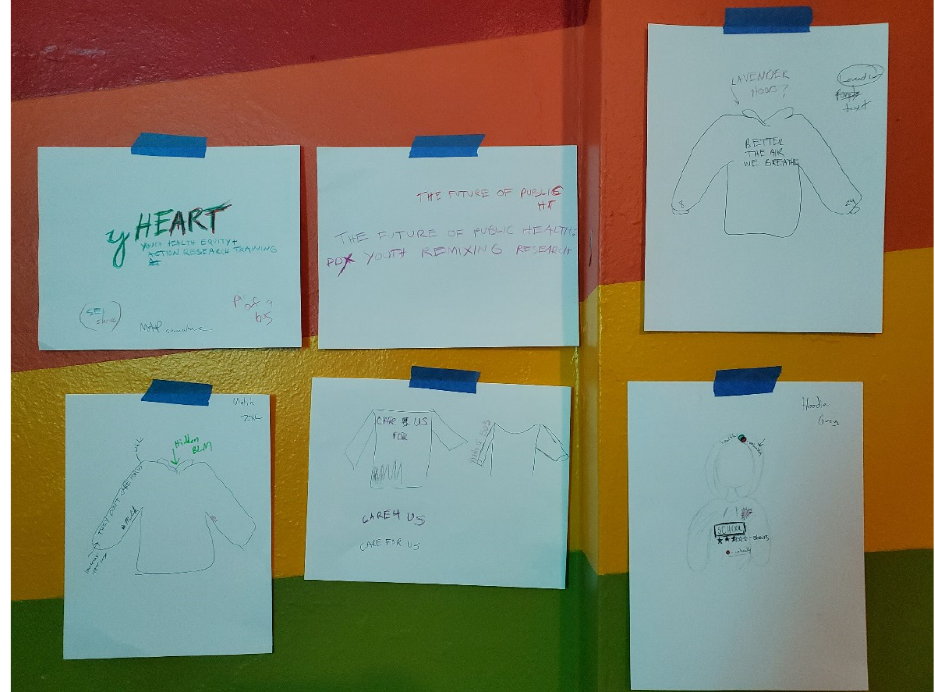
Figure 5. Draft illustrations of some of the youth researchers’ custom-designed hoodies.